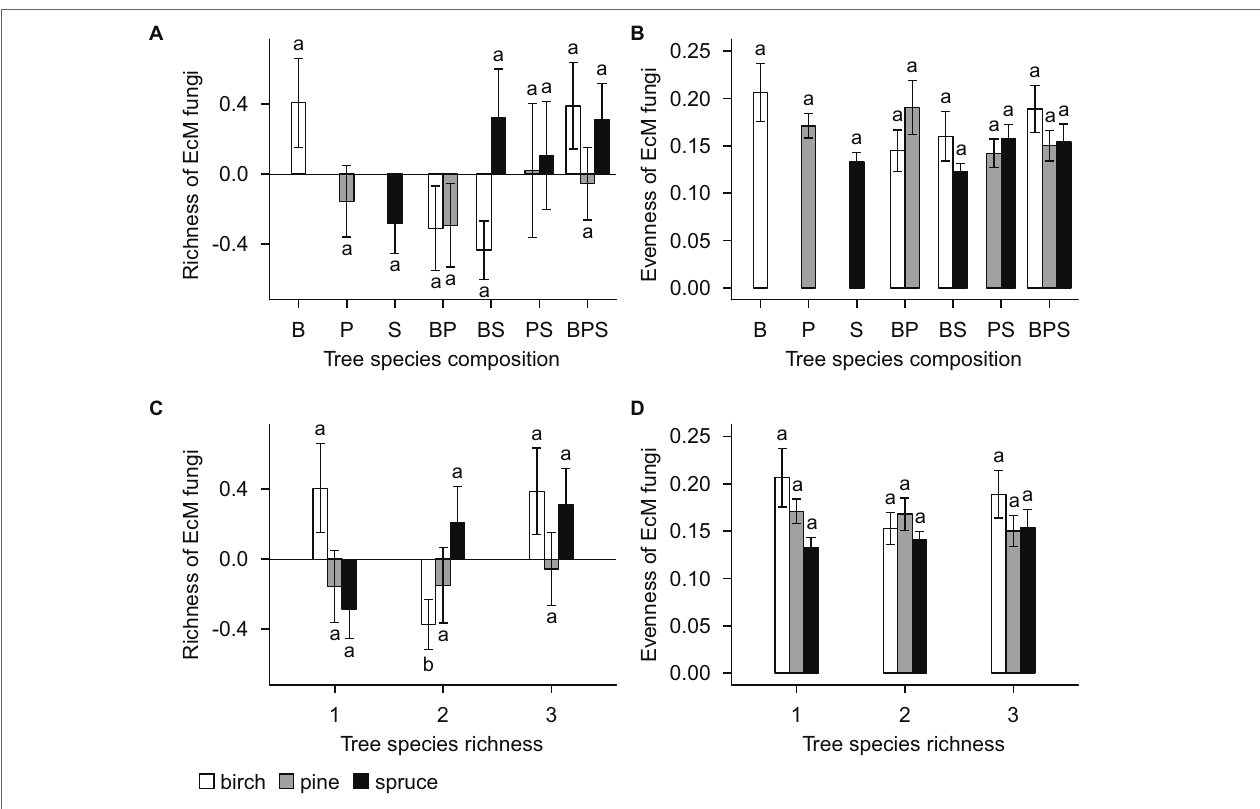
FIGURE 4 | (A) Tree species composition and (C) tree species richness effects on richness of EcM fungi. (B) Tree species composition and (D) tree species richness effects on evenness of EcM fungi. EcM fungal richness estimation is based on standardized residuals. Data represent the means of all samples with SEs. Different letters denote significant differences ( p < 0.05) among factor levels. B, birch; P, pine; S, spruce; BP, birch-pine; BS, birch-spruce; PS, pine-spruce; BPS, birch-pine-spruce; 1, monospecific; 2, two-species mixtures; and 3, three-species